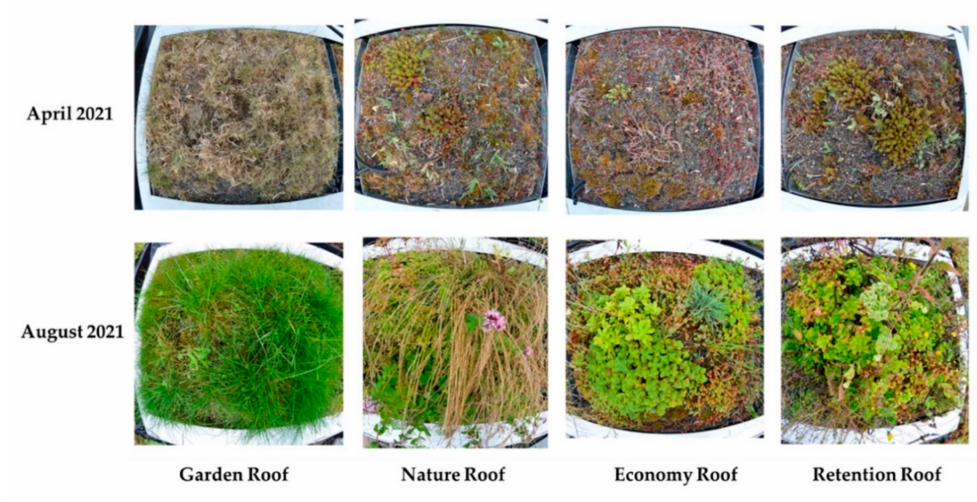
Figure A2. Exemplary photos of the four experimental roofs in April and August